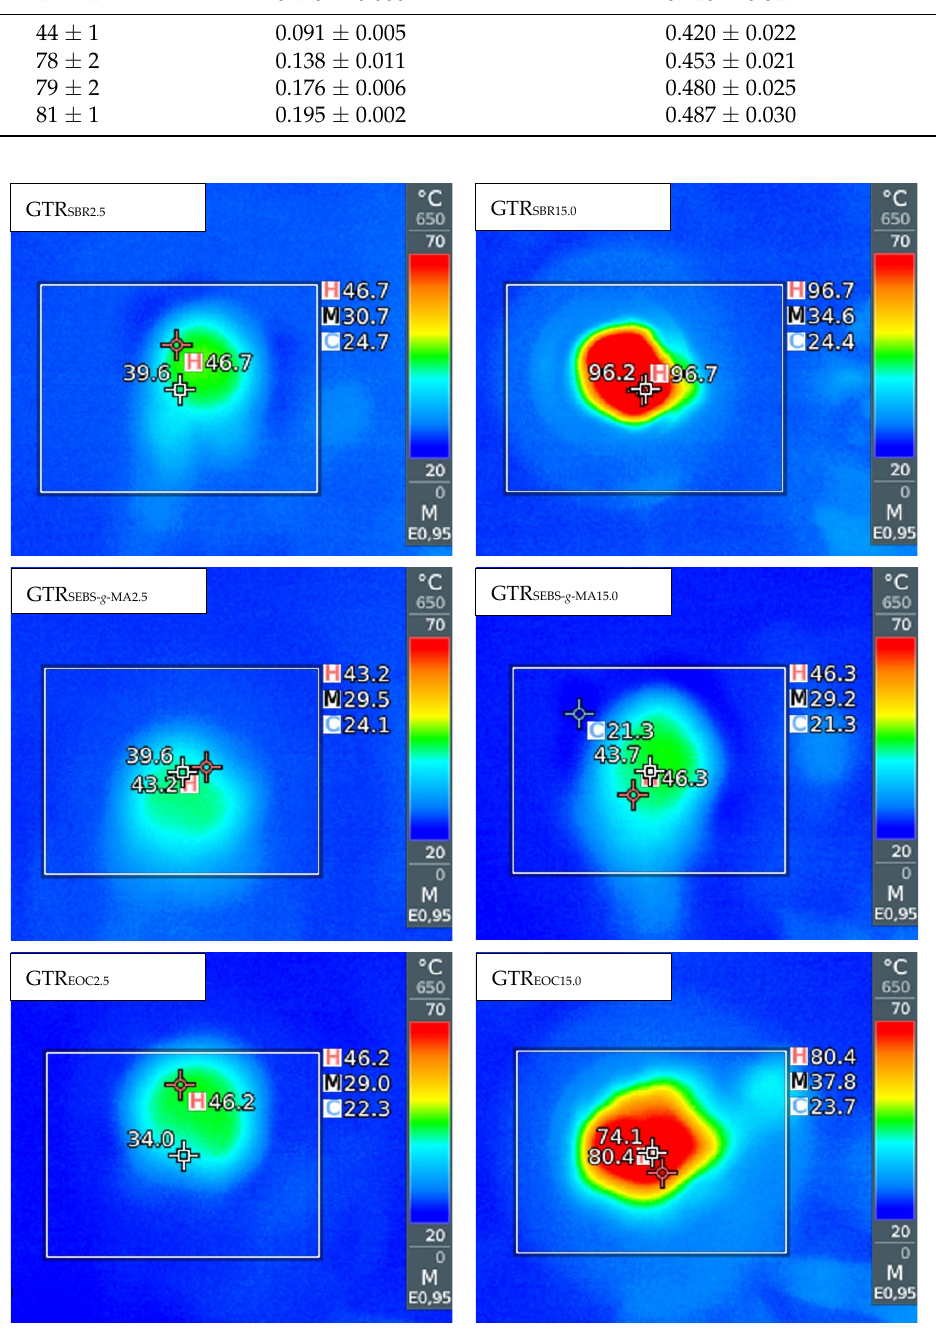
Figure 2. The infrared camera images for selected